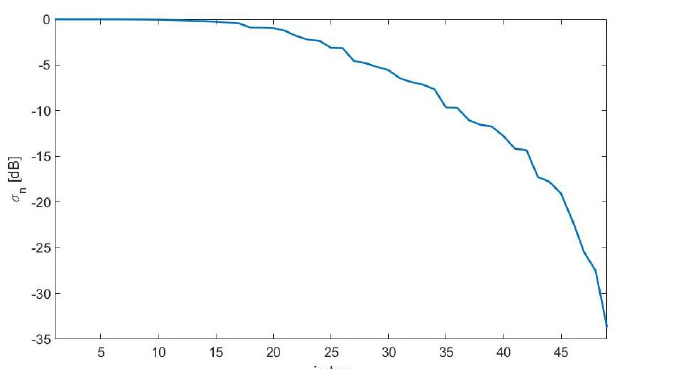
Figure 15. SVs for the horn antenna case.